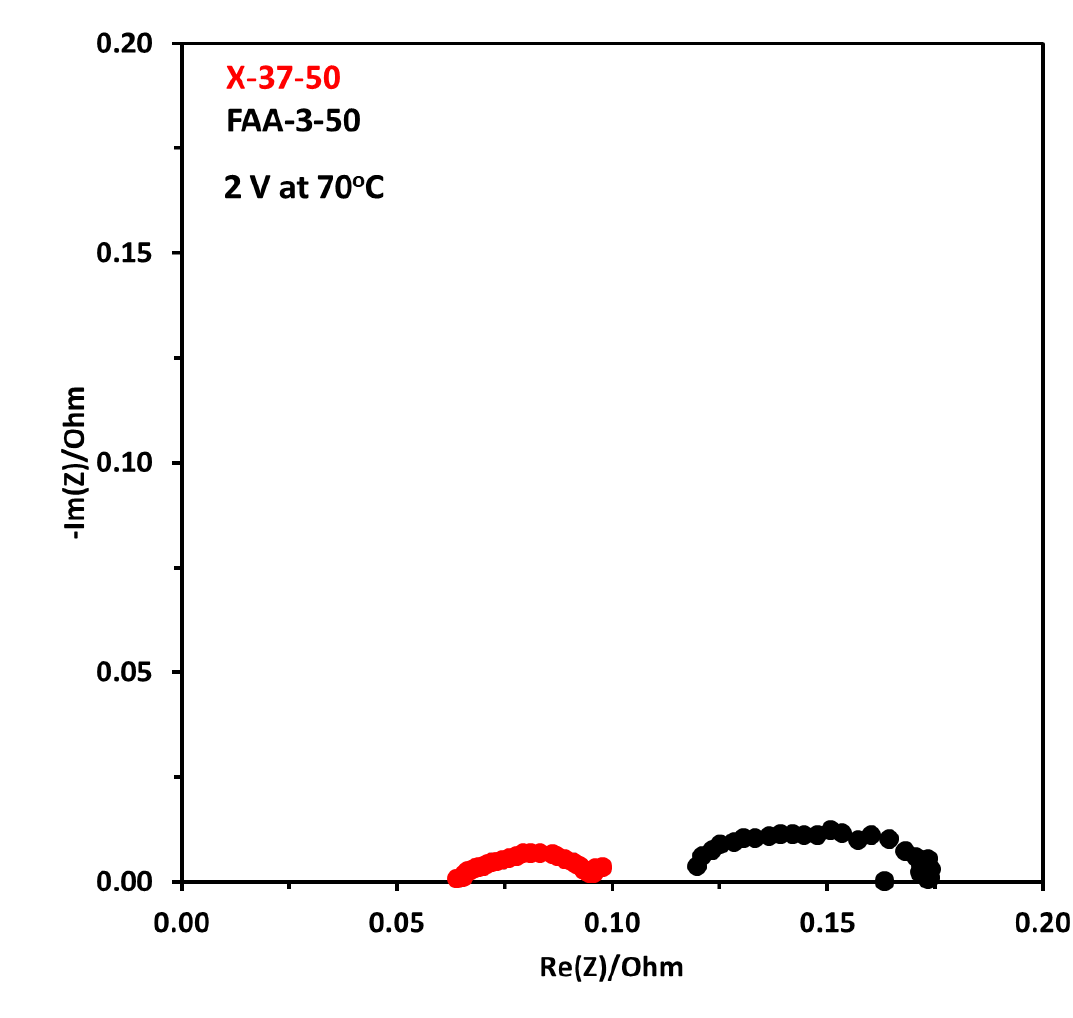
Figure 13. Comparison of electrolysis performance using X-37-50 and FAA-3-50 membranes at different temperatures using NiFeCoO x catalyst; ( a ) 45 ◦ C, ( b ) 55 ◦ C, ( c ) 70 ◦ C.